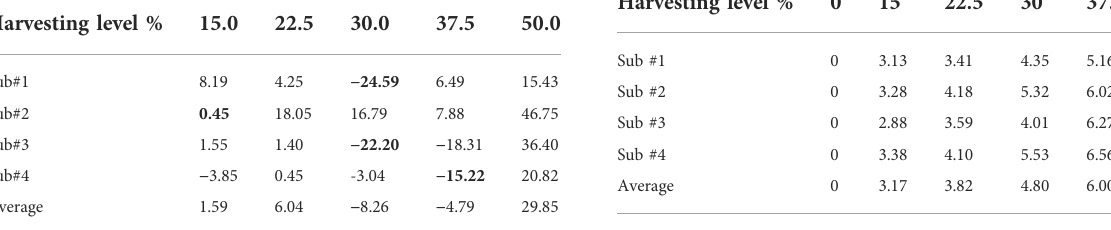
TABLE D1 Metabolic power differences (Harvesting-Disconnected); bold indicates the lowest number for each subject.